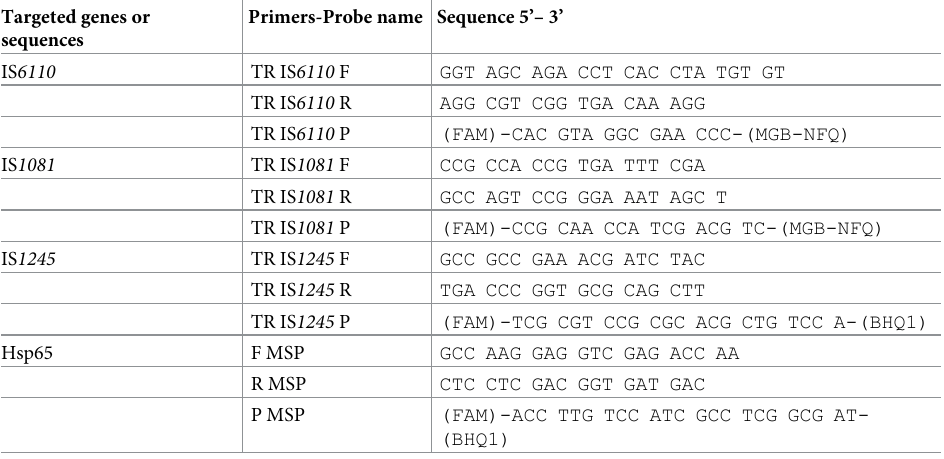
Table 1. Primers and probes oligonucleotides for real-time-PCR assays used in this study. Targeted genes or